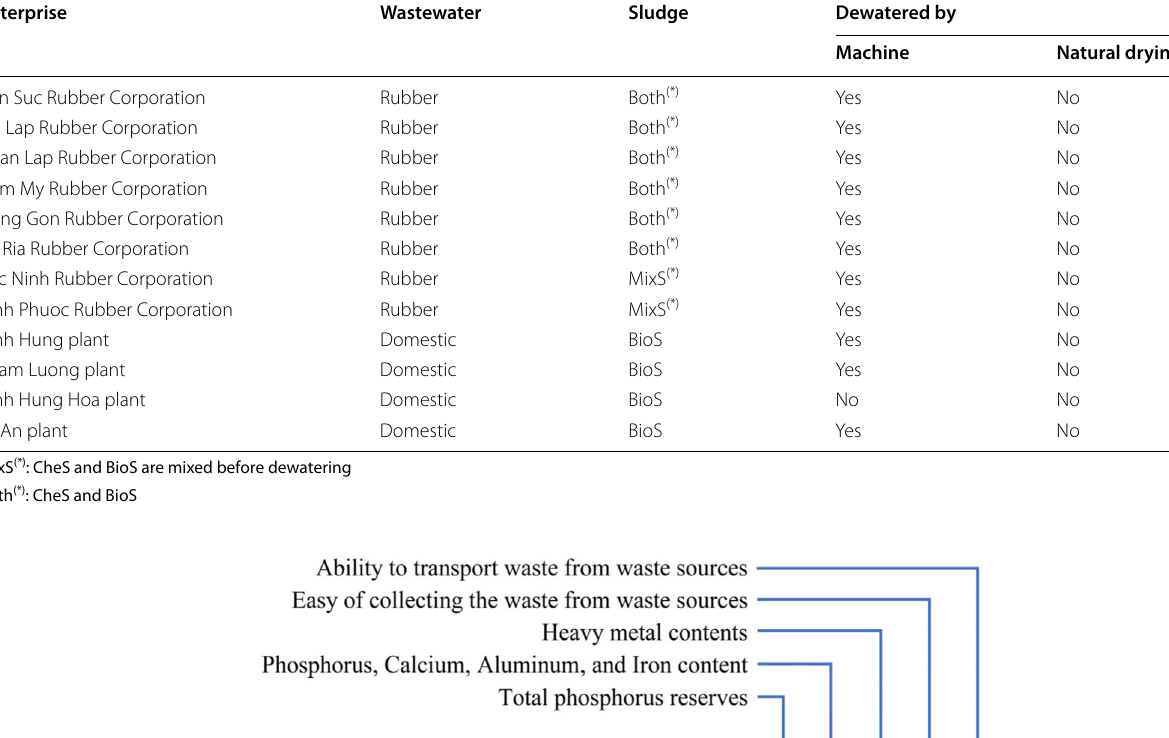
Table 6 Sludge type and dewatering method at RWWTP and DWWTP via survey data